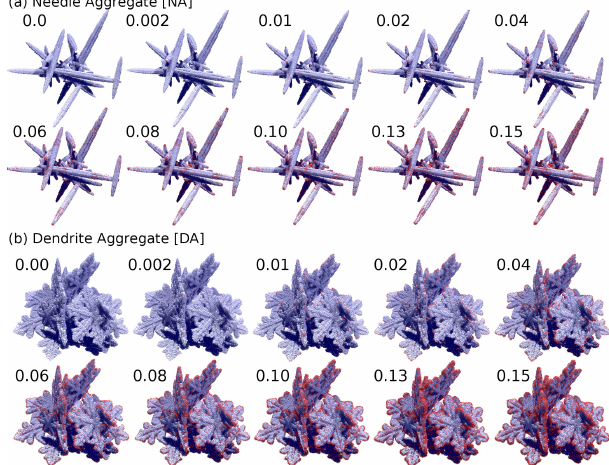
Figure 1. Selected steps in the onset of melting for (a) needle ag- gregate (NA) and (b) dendrite aggregate (DA). Blue regions are ice, and red regions are liquid water; mass fraction of meltwater is indi- cated at each step. Particle mass is conserved throughout the melting